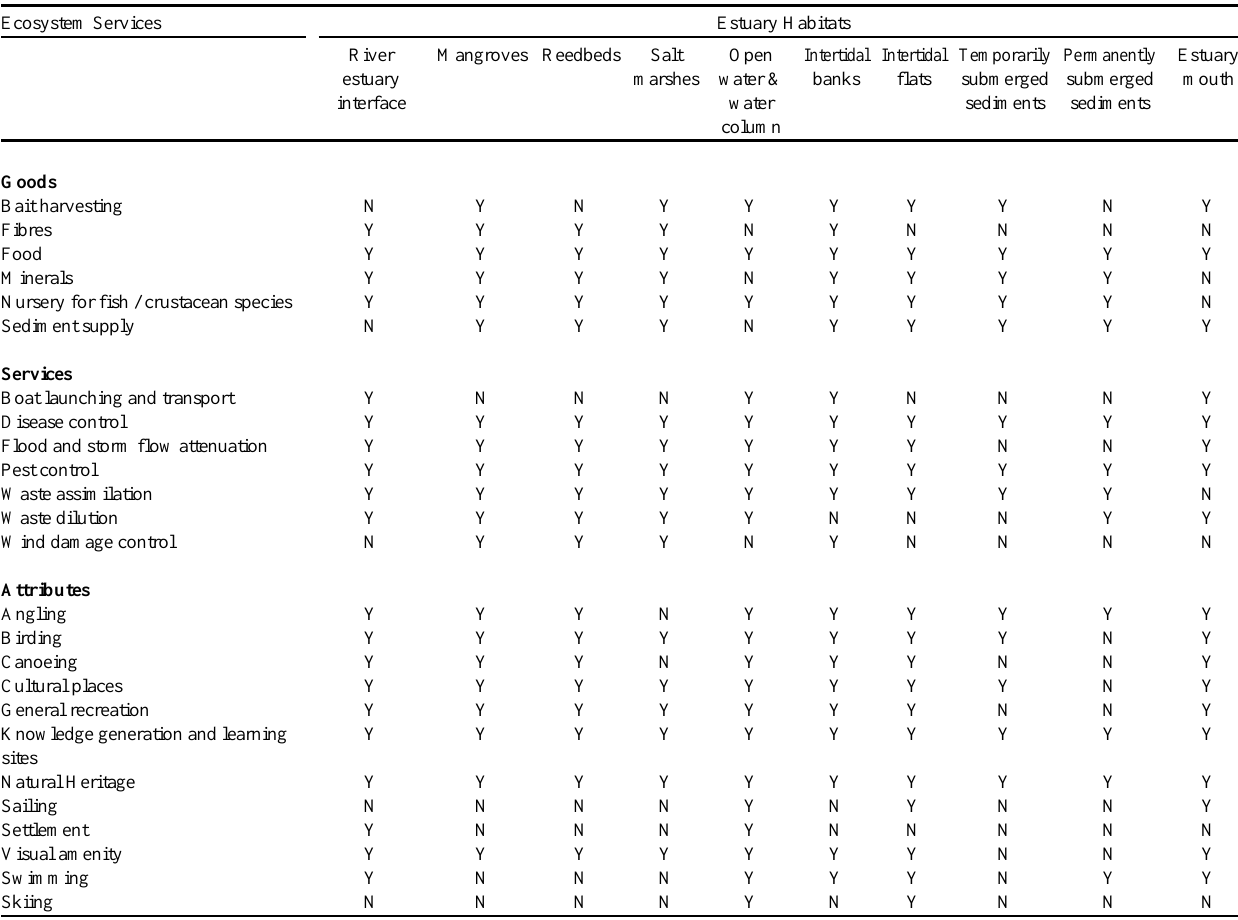
Table 1 . Comprehensive list of estuary habitats and associated ecosystem services found in South Africa (Y = yes, N = no). Ecosystem